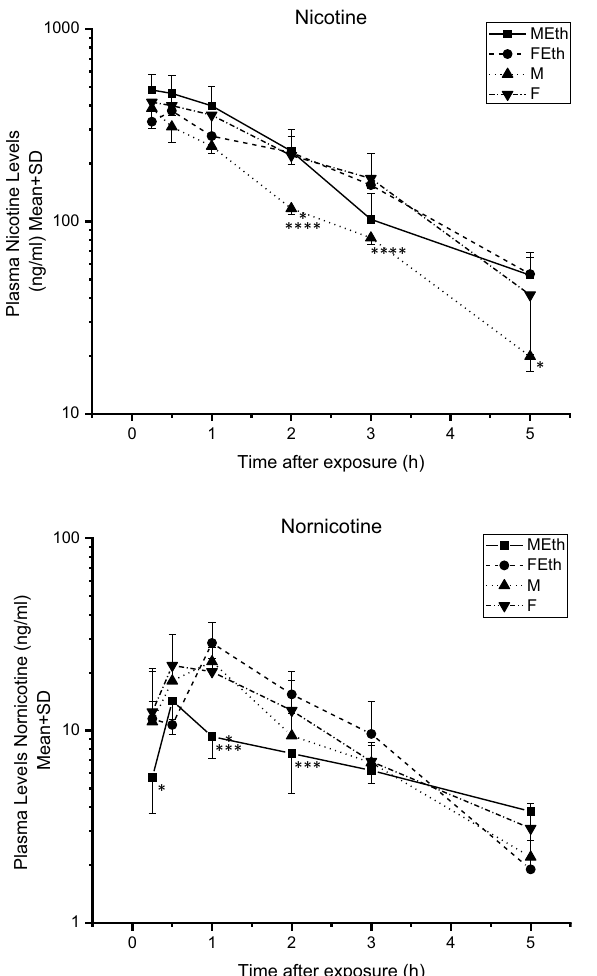
Figure 3. Plasma nicotine and nornicotine levels measured over time—rats exposed to tobacco smoke at a concentration, expressed as carbon monoxide, 1500 mg CO/m 3 for 5 days, 6 h a day. Asterisks indicate a significant difference value (P < 0.05): *MEth vs M, **FEth vs F, ***MEth vs FEth and ****M vs